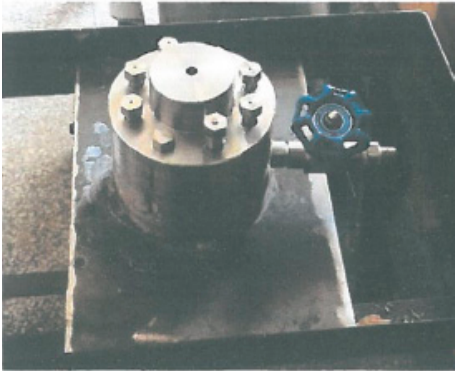
Figure 10. Test equipment.